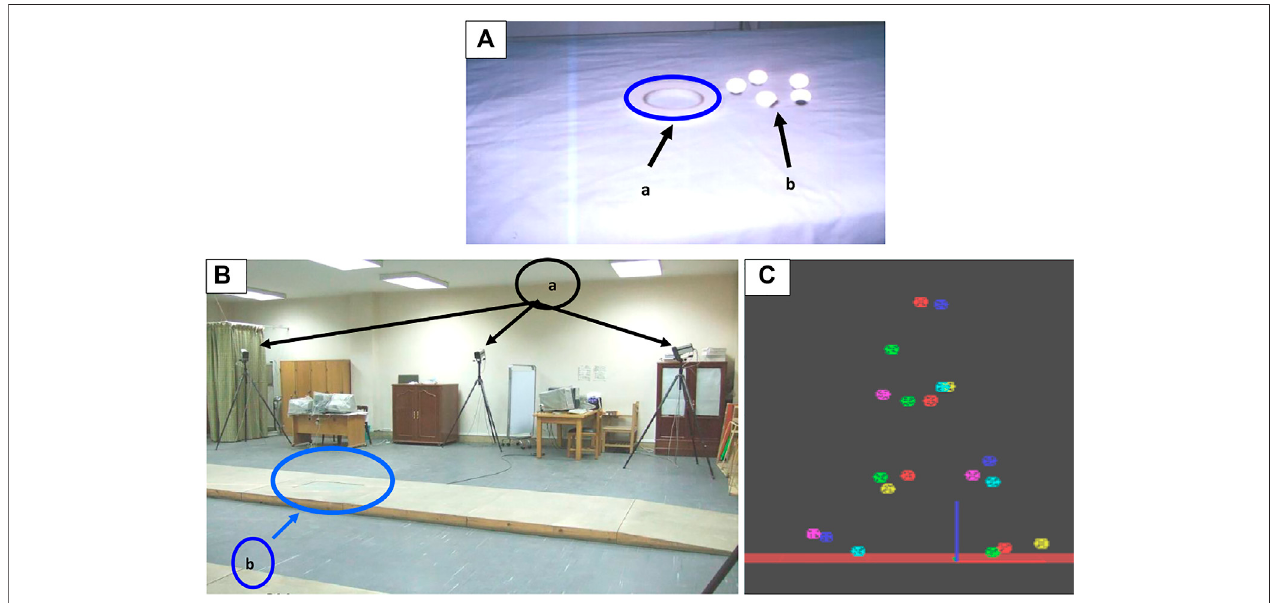
FIGURE 2 | (A) Adhesive tapes (a) and the re fl ective markers (b) were used to fi x the markers. (B) Biomechanical lab, which includes the placement of the Pro- Re fl ex cameras (a) in relation to the walkway and the force plate position (b) in the center of the walkway. (C) Exported data format, data TSV (tab-separated